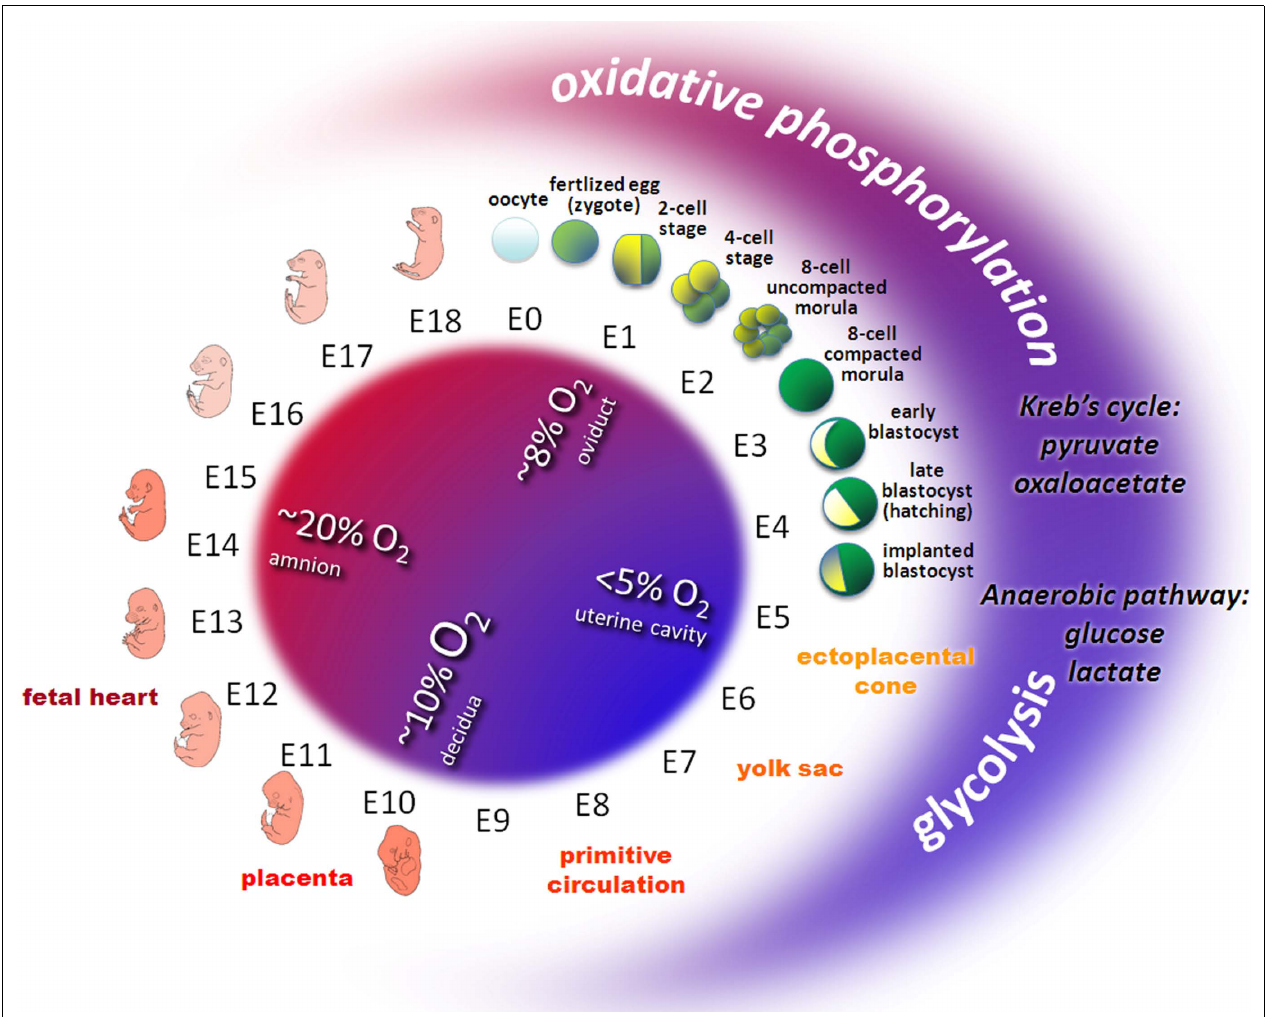
area, ∼ 8% O 2 ) and low glucose to anaerobic (blue area, <5% O 2 ) and high glucose conditions. Redox metabolism transits from oxidative phosphorylation (low glucose, high oxygen) to glycolysis (high glucose, low oxygen). Pyruvate or oxaloacetate are essential substrates during early cleavage whereas glucose and lactate prevail from the eight-cell stage embryos to peri-implanted